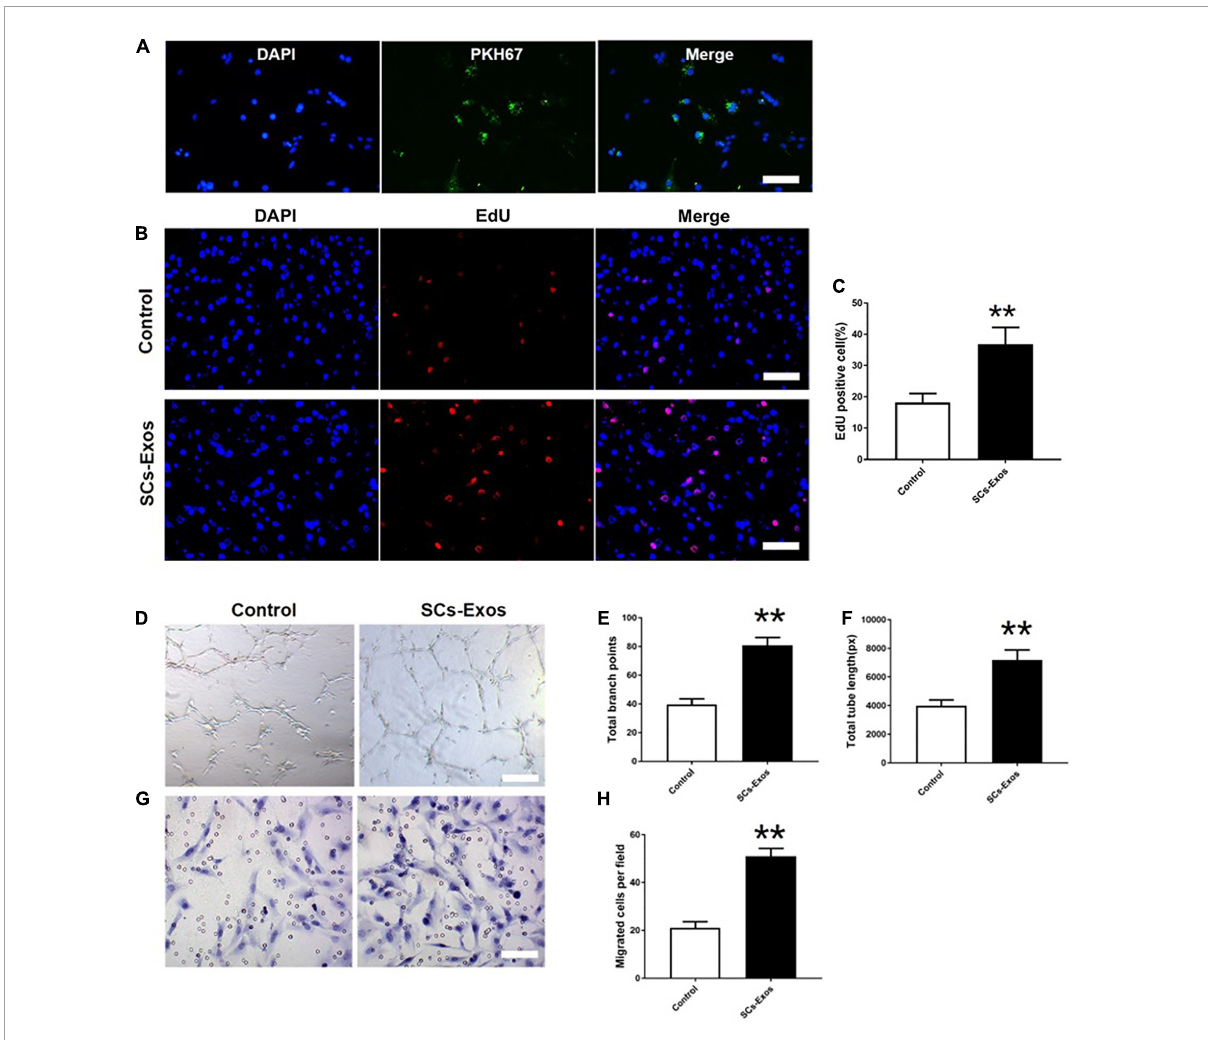
FIGURE2 Schwann cells-derived exosomes enhance the angiogenic activities of Endothelial Cells. (A) Immunofluorescence images of PKH67-labeled exosomes taken up by bEnd.3 cells. Scale bar = 50 µ m. (B) The proliferation of bEnd.3 cells was performed by the EdU test. (C) Quantitative analysis of EdU-positive cells in each group. (D–F) Tube formation and migration were measured by the capillary network formation assay and transwell chamber migration assay 6 h after seeding bEnd.3 cells pretreated with PBS, or SCs-Exos. Photomicrographs of tube-like structures and quantification of the tube number. (G) Photomicrographs of bEnd.3 cells that migrated through the Transwell R (cid:13) membrane. The bEnd.3 cells were stained with crystal violet. (H) Quantification of the number of the migrated bEnd.3 cells. The data are presented as mean ± SD. ** p < 0.01 SCs-Exos vs. Control group. N = 5 in each group. Scale bar = 500 µ